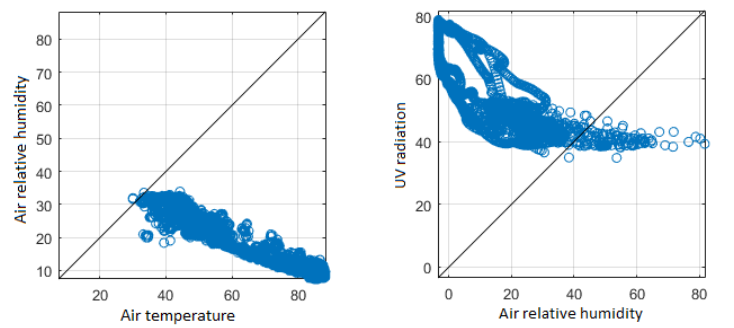
Figure 14. Scatter diagrams of the variables with direct and inverse relationship of the ZigBee network, from top to bottom.